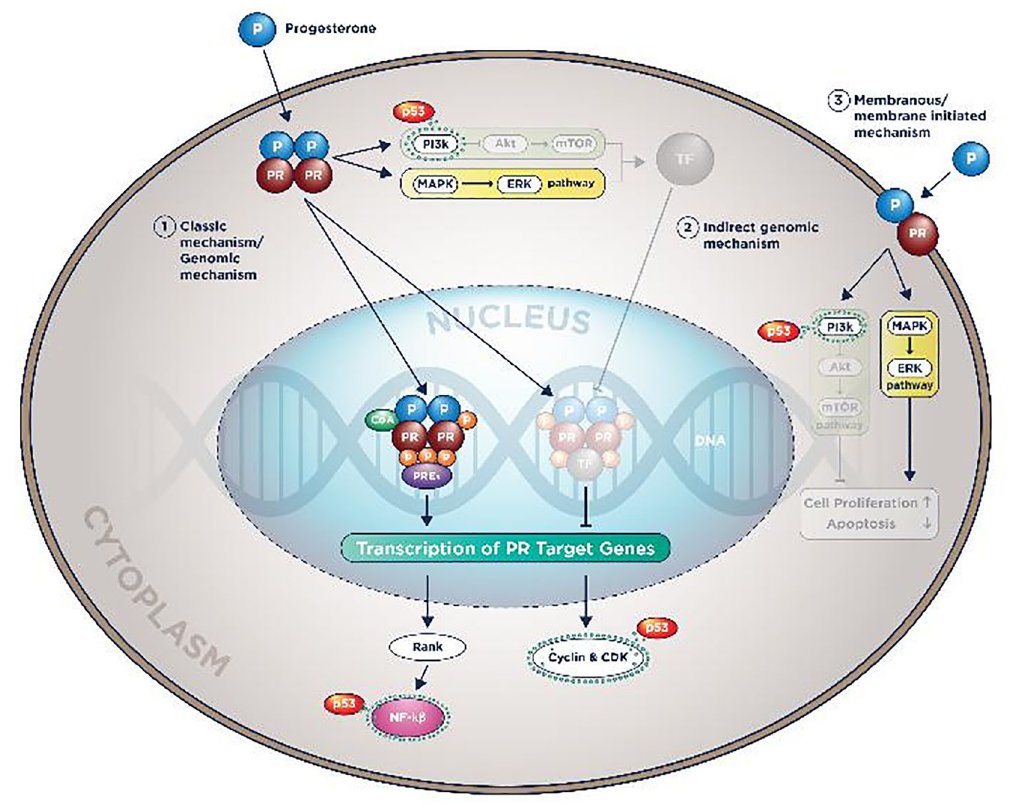
Figure 4. Plausible p53 wild-type roles in reducing endocrine therapy resistance by prohibiting PR molecular